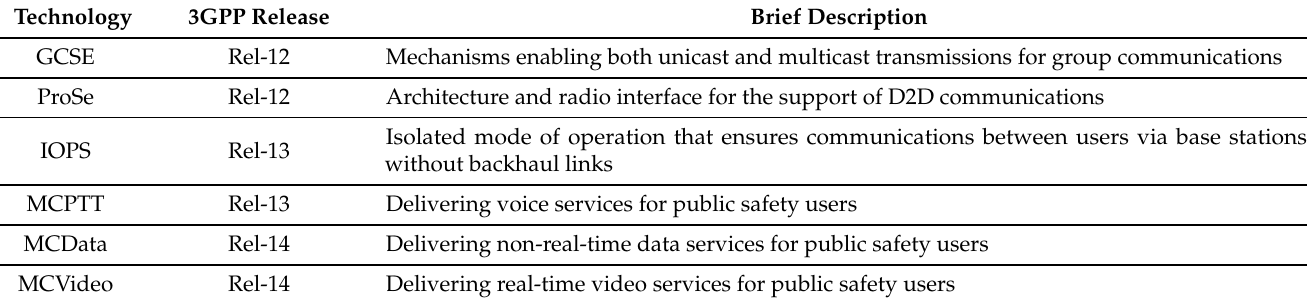
Table 1. Main cellular solutions for public